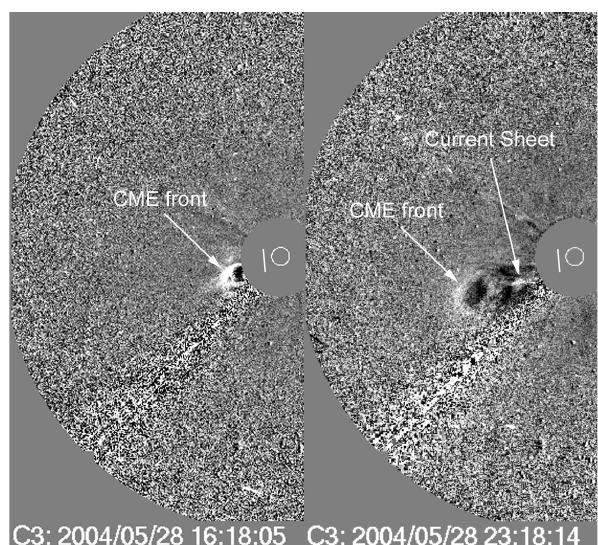
Fig. 5. LASCO C3 running difference images at 16:18 and 23:18UT, on 28 May 2004, showing the morphology of the CME at a time when the CME front and bubble are seen in the C3 field of